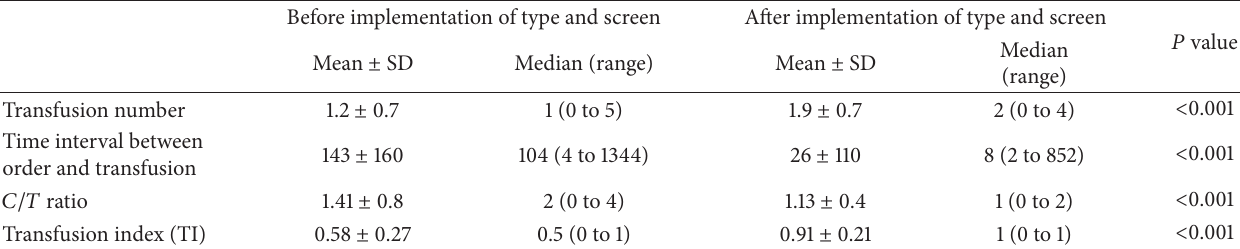
Table 2: Blood transfusion data of 944 patients during the period of study. Before implementation of type and screen After implementation of type and